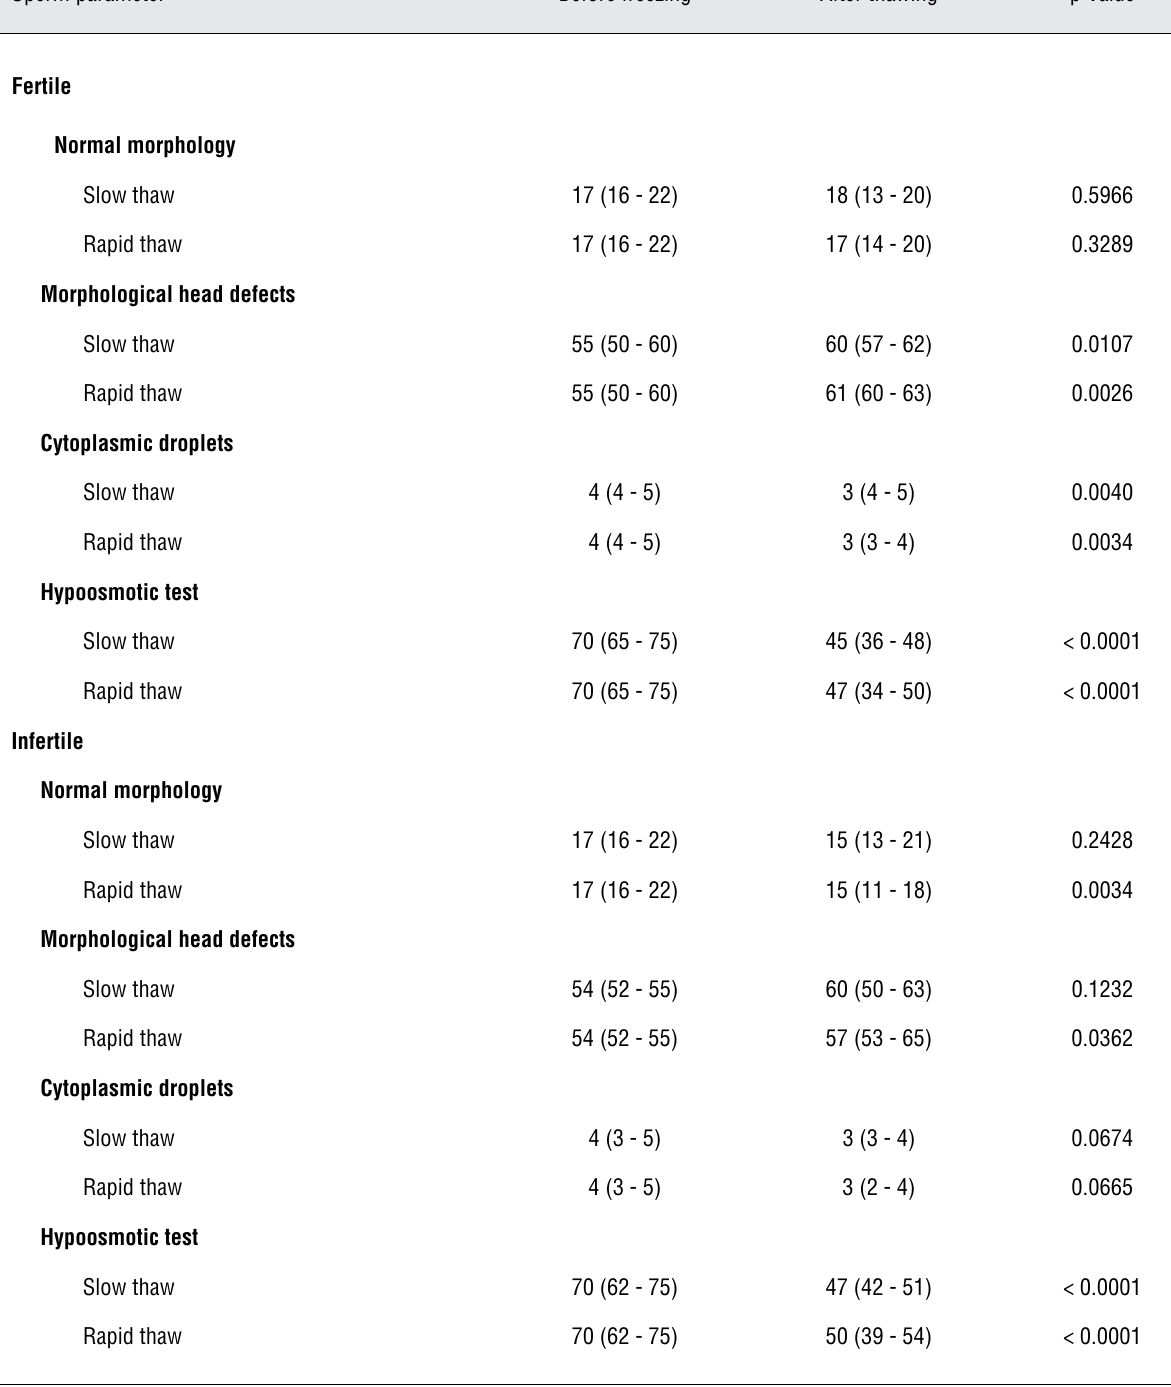
Table 3 – sperm parametere before and after cryopreservation. Sperm